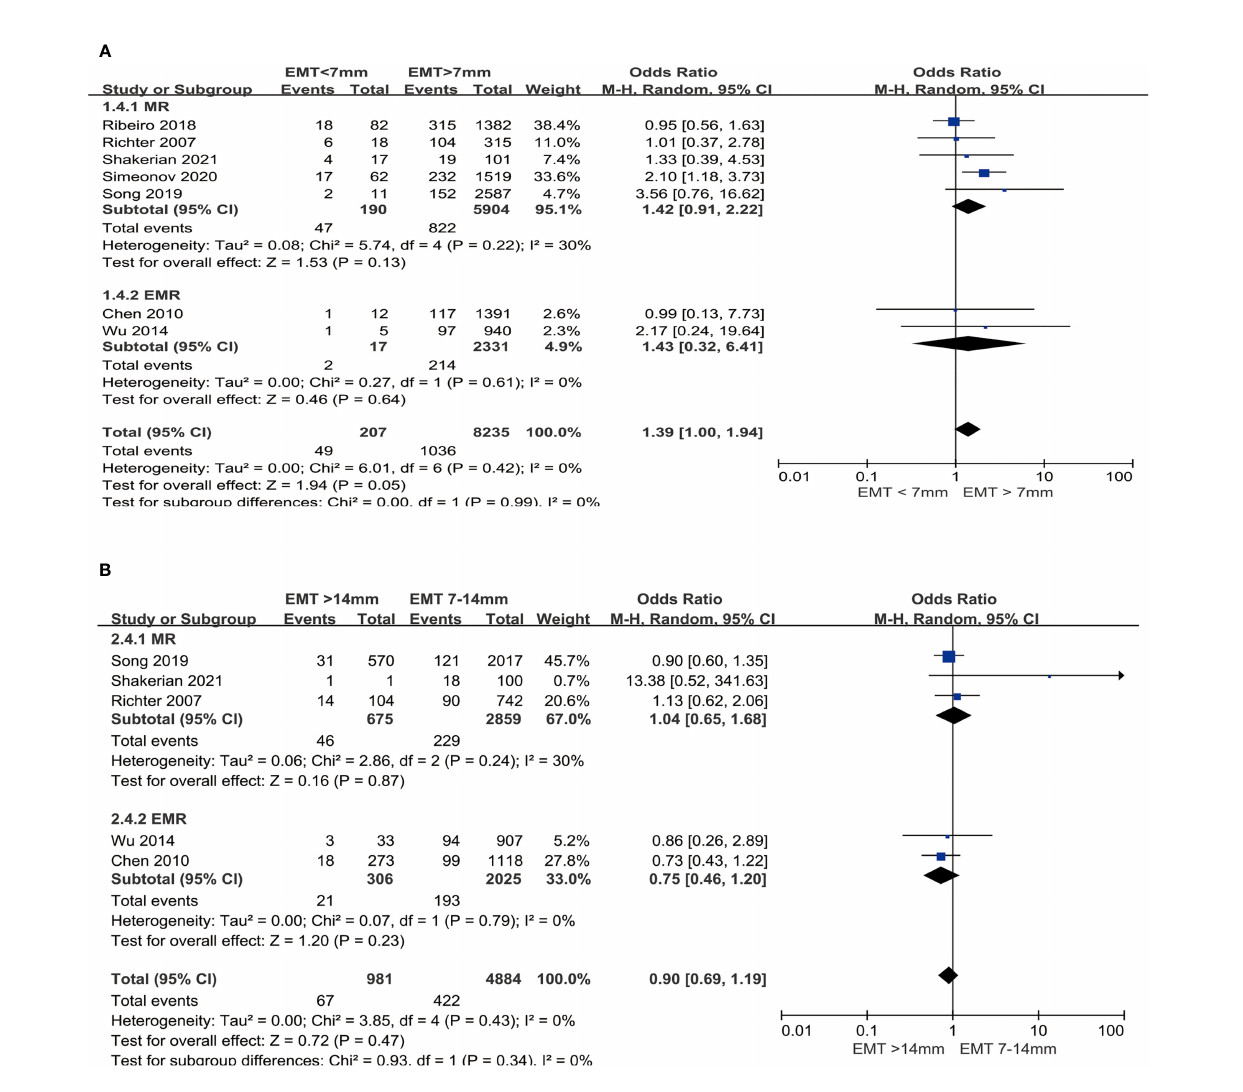
FIGURE 5 | Comparison of MR between EMT groups in fresh cycles. (A) Comparison between thin endometrium group and non-thin endometrium group. (B) Comparison between thick endometrium group and medium endometrium. MR, Miscarriage rate; EMR, Early miscarriage